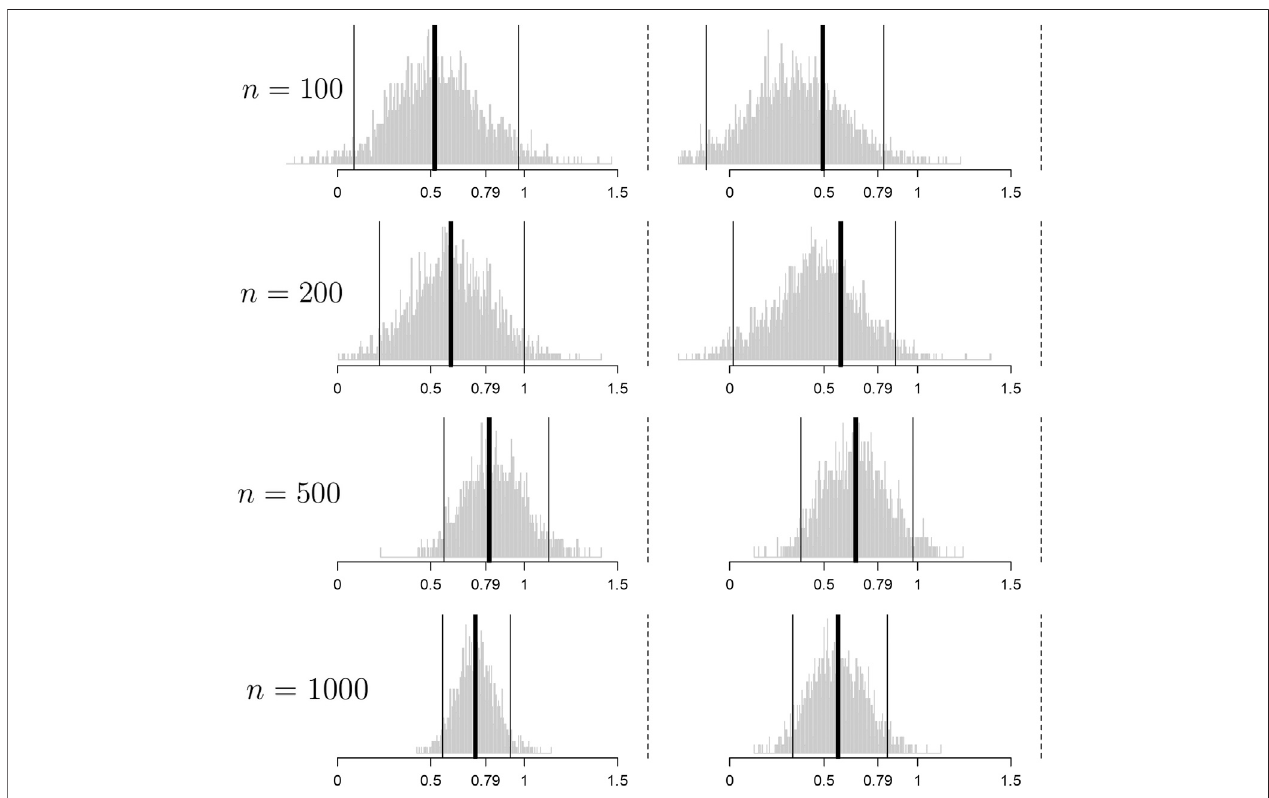
FIGURE 3 | Histograms of the bootstrap samples of the cross-validated improvement measures for d 0 random (left column) and d 0 best (right column) for the response model of Eq. 12 for different values of n . (cid:12) I 0 isillustrated with a thick black line. The CI μ computed via the percentile method isillustrated by thin black lines. I 0 , 95 % The true population improvement μ * I given the optimal rule d * is illustrated with a dotted black line. 0